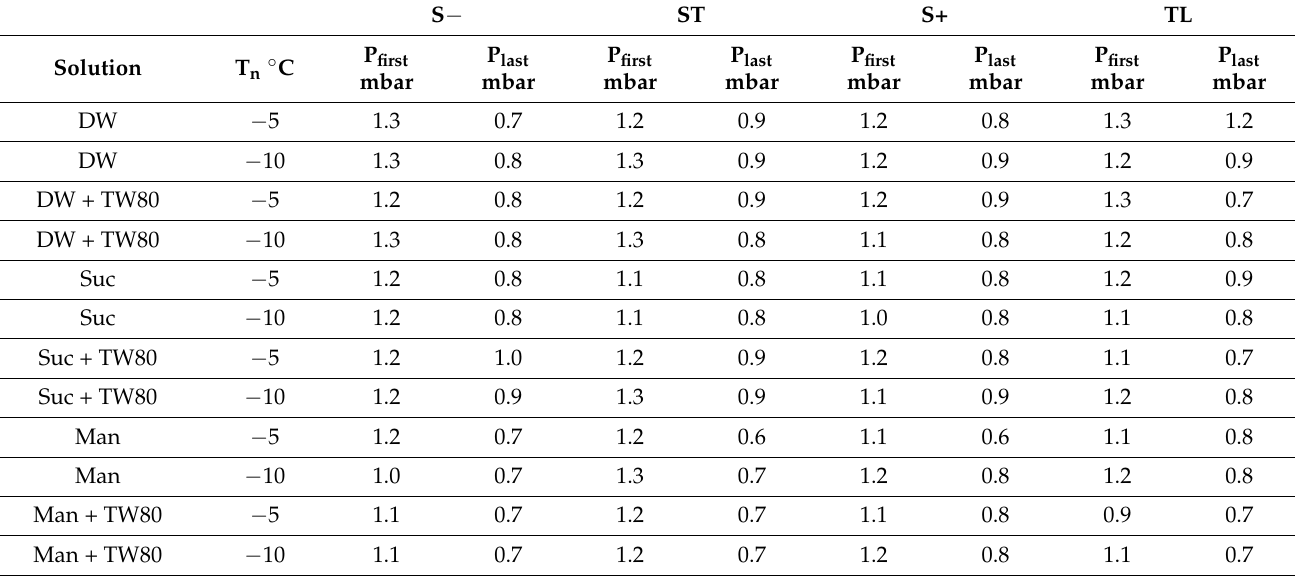
Table 2. P first and P last values for the different solutions and vial types considered in this work. S − : untreated, ST: sulfate treated, S+: siliconized, TL: